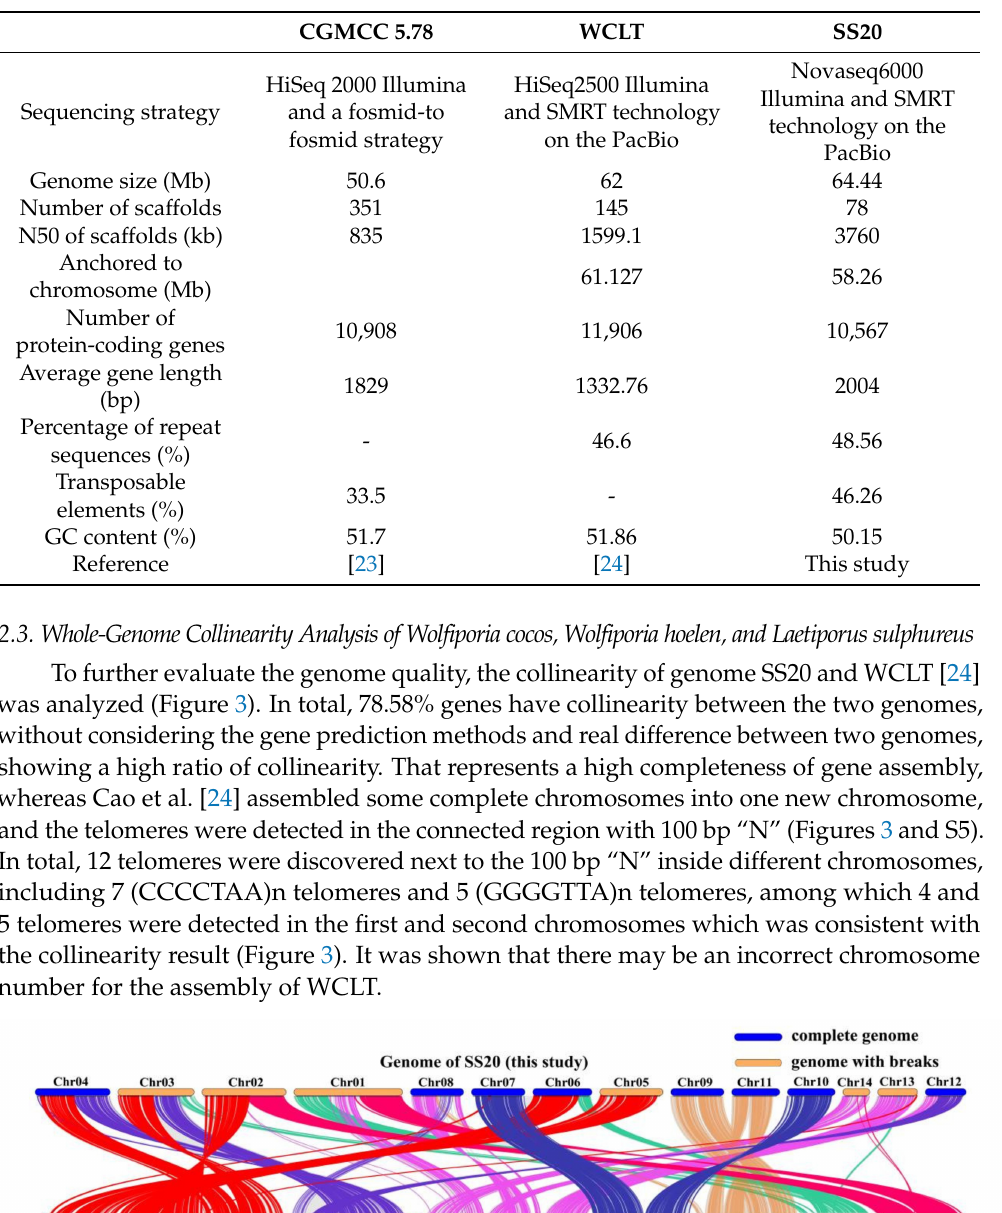
Table 2. Genome characteristics of strains of W. hoelen .